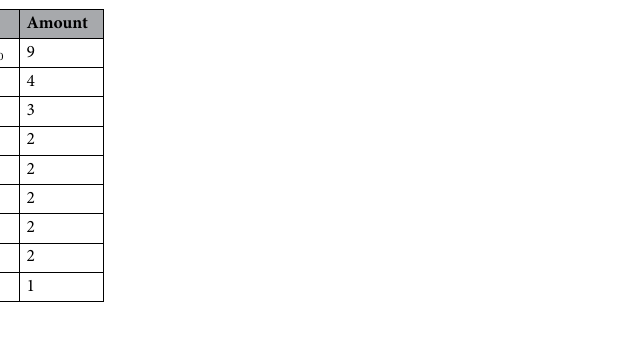
Table 4. Factor classification